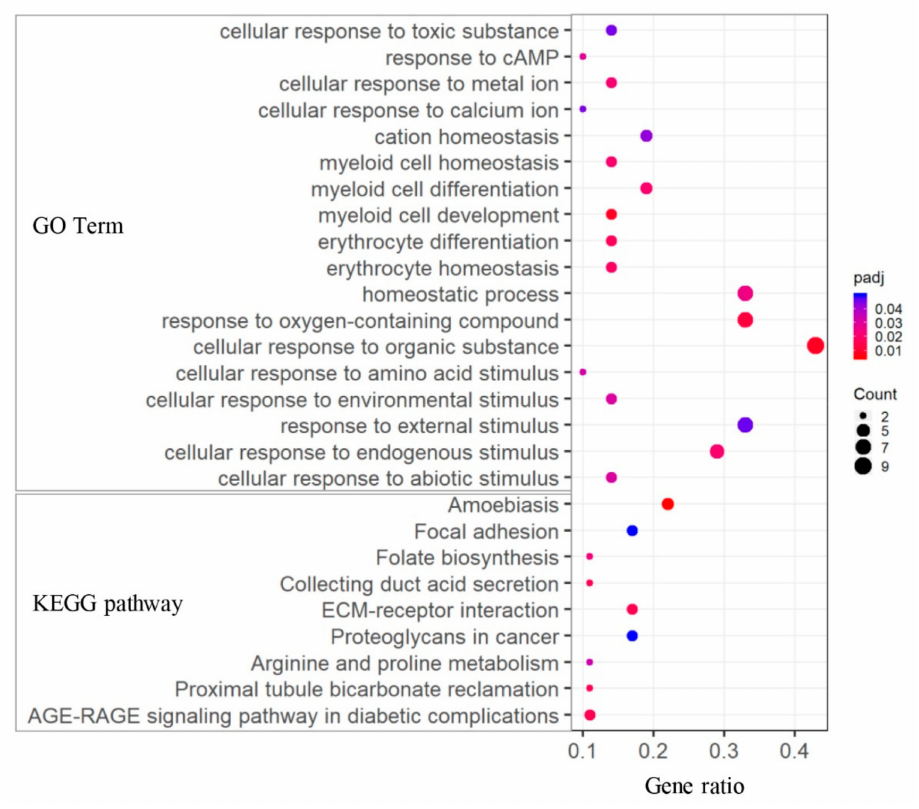
Figure 5. GO and KEGG analyses of DEGs between CK and HC